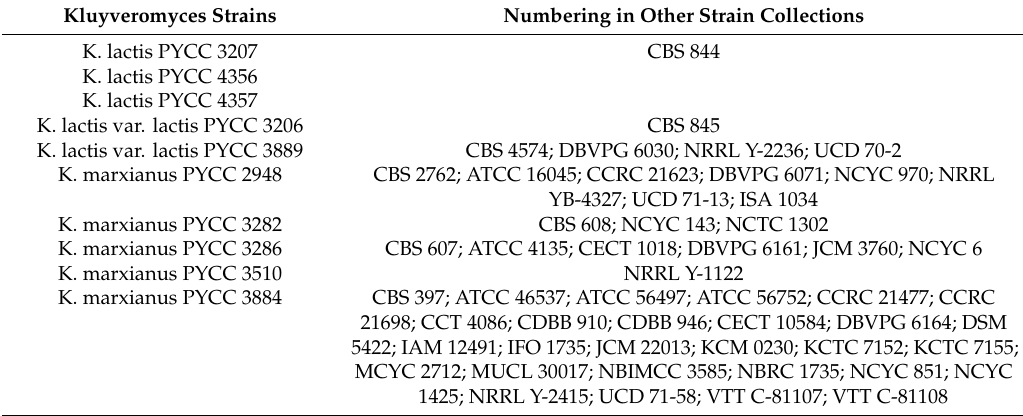
Table 1. List of Kluyveromyces strains used in this